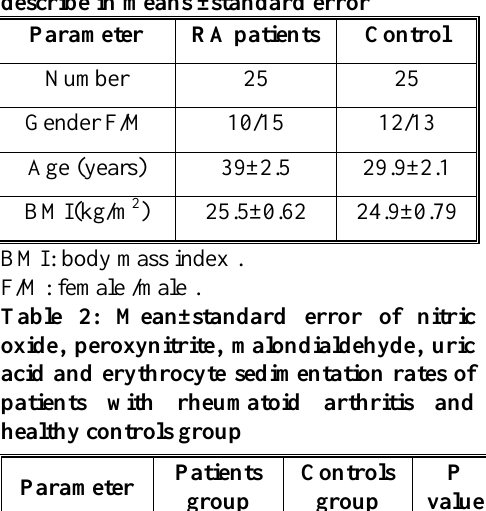
Table1:Demographic data of studied groups describe in means ±standard error Parameter